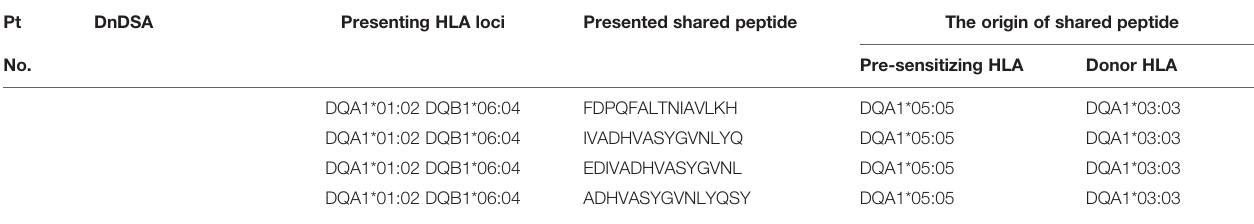
TABLE 7 | Characteristics of shared pHLAs; comparison of 3-year dnDSA- positive versus negative group in the shared TE-positive group.